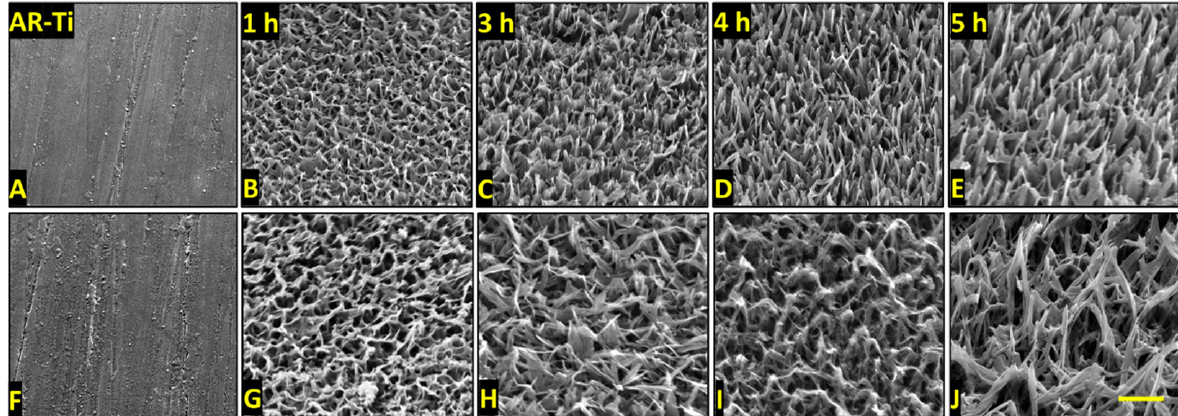
Figure 1. SEM micrographs showing the morphology and distribution of nanoarchitectures obtained after etching the surface for AR-Ti, 1, 3, 4, and 5 h using either NaOH ( A – E ) and KOH ( F – J ) aqueous-based etching solutions. Images were acquired at 50,000 magnification with 45° stage tilt, scale bar bottom left panel represents 500 nm.